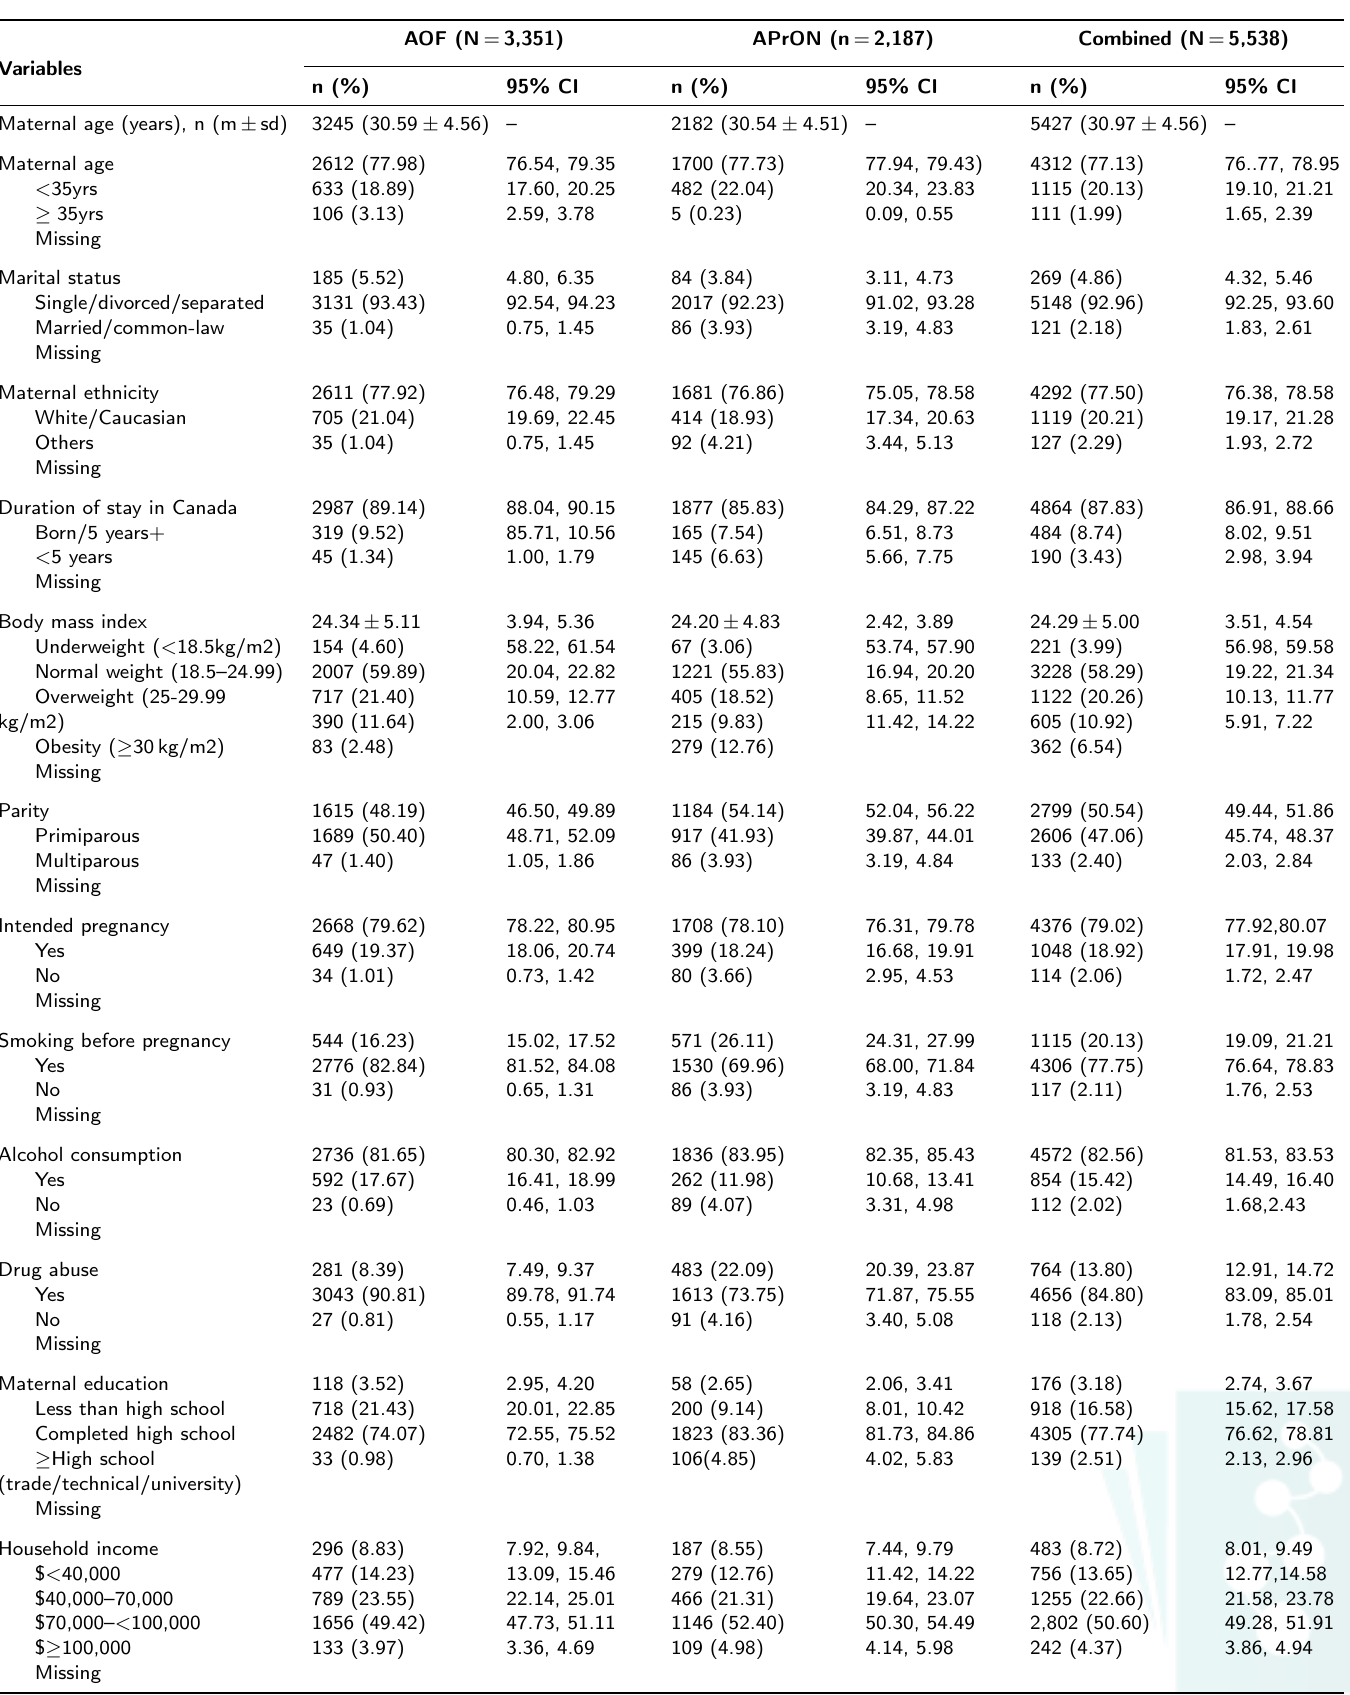
Supplementary Table 3: Characteristics of All our Family (AOF) cohort, Alberta Pregnancy Outcomes and Nutrition (APrON) cohort, and combined